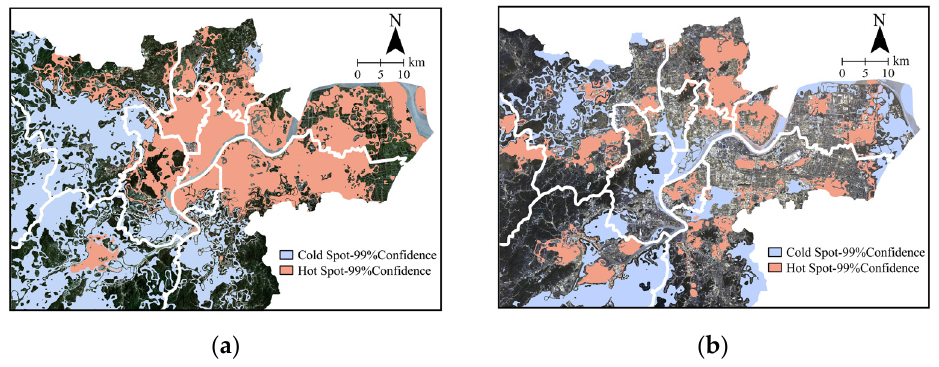
Figure 11. Distribution of cold and hot spots of emotional health risk during the two periods: ( a ) 1984–1998; ( b ) 1998–2020.